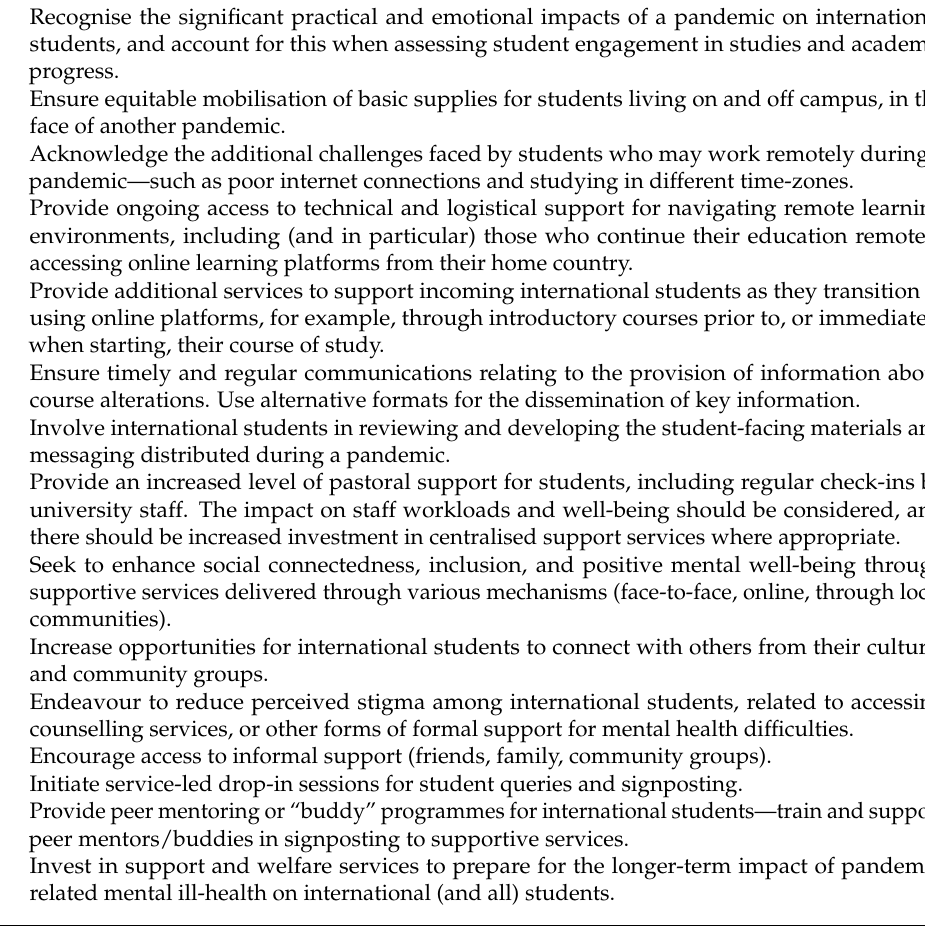
Box 1. Recommendations and strategies to minimise psychological impacts of a pandemic for international